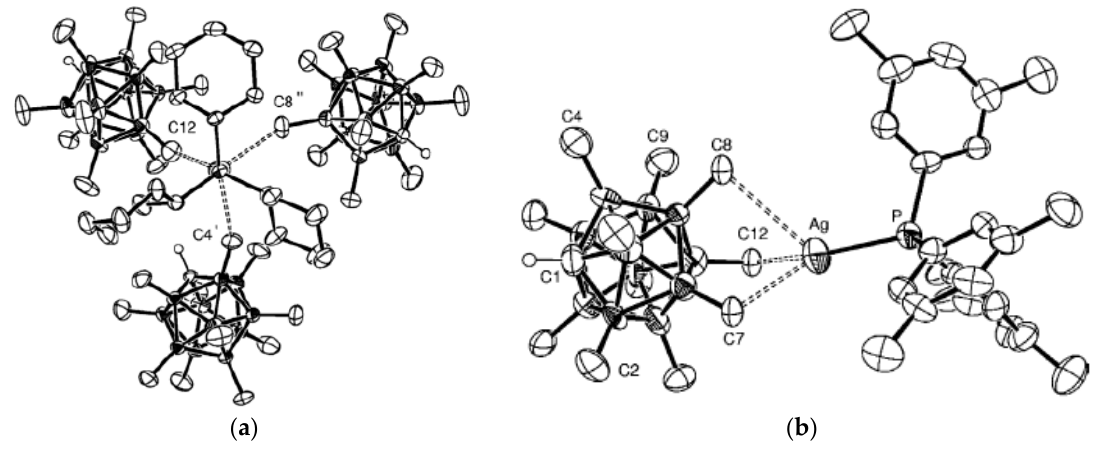
Figure 95. X-ray structures of {(Cy 3 P)Ag[HCB 11 Me 11 ]} ( a ) and {((3,5-Me 2 C 6 H 3 ) 3 P)Ag[HCB 11 Me 11 ]} ( b ). Reprinted with permission from reference [104]. Copyright © (2004) American Chemical Society.